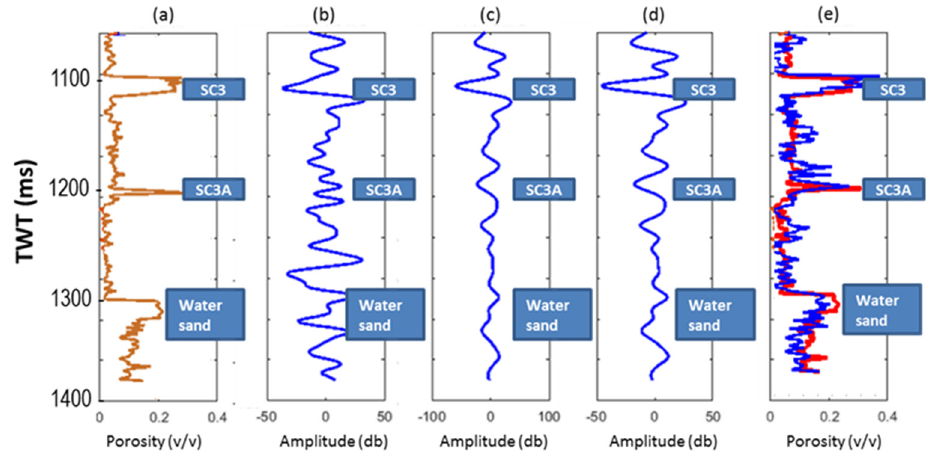
Figure 11. Porosity inversions at Well 1 location. ( a ) porosity log, ( b ) near seismic trace, ( c ) Far seismic trace, ( d ) traditional inverted EEI porosity, ( e ) porosity log (red) overlaid by proposed in ‐ verted EEI porosity (blue). “SC3”, “SC3A”, consecutively, locate the anomalous thick and thin gas reservoir sand and “Water sand” locates the deeper water sand.